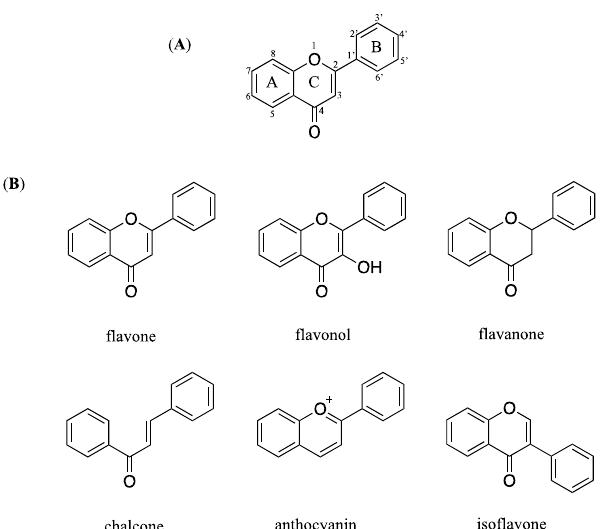
Figure 6. Chemical structure of flavonoid ( A ) general chemical structure ( B ) main structures classed of flavonoids.